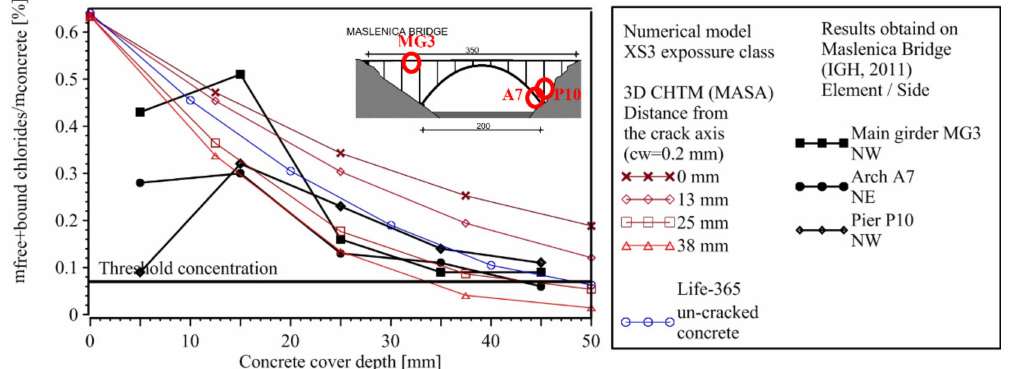
Figure 6. The total chloride content in concrete after 13 years of sea exposure: comparison of the numerical results and measured values on the Maslenica Bridge (reproduced with permission from [40], IOP Proceedings,